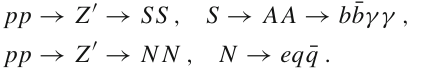
vals selected, an additional improvement by a factor of 2